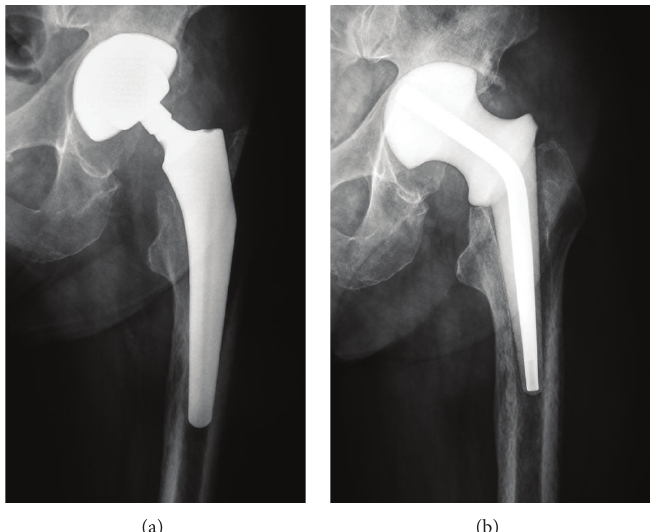
Figure1:PreoperativeX-rayofatotalhiparthroplastycomplicatedbychronicinfection(a).Radiographobtainedafterremovaloftheinfected prosthesis and implantation of an industrially manufactured spacer (b).